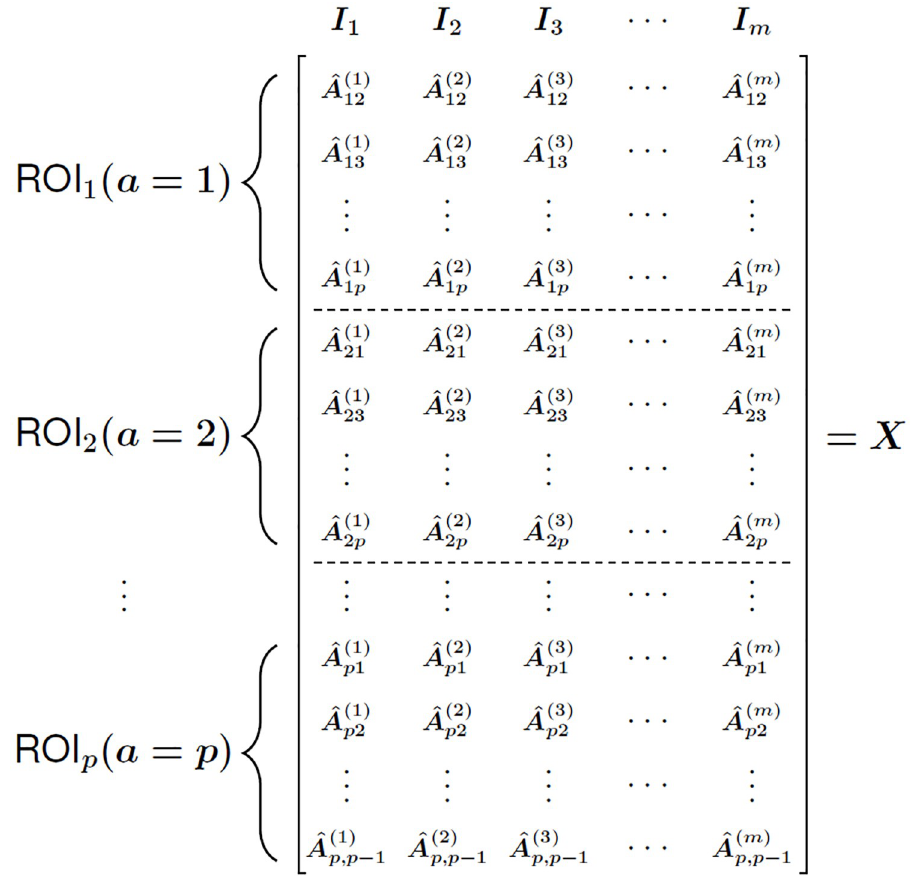
Fig 9. Organization based on brain regions of interest (ROIs) of resting-state fMRI correlation dataset consisting of transformed correlation matrices for m subjects. Each column corresponds to an instance (or subject) I and each j subset of rows corresponds to the correlations for an ROI attribute ( p sets). The notation ^ A ð j Þ represents the r-to-z ak transformed correlation between attributes (ROIs) a and k 6¼ a for instance j . represent ROI , and so on until the last p − 1 rows that represent ROI . For a given column of 2 p X , we exclude pairwise correlations between an ROI and itself. Therefore, the matrix does not contain ^ A ð i Þ for any i 2 I or a 2 A . Furthermore, symmetry of correlation matrices means aa that each column contains exactly two of each element of the upper triangle of an instance’s transformed correlation matrix. For example, ^ A ð i Þ ¼ ^ A ð i Þ for k 6¼ a and both will be contained ka ak in a given column of X for each a 2 A . Based on our rs-fMRI diff (Eq 157), the organization of X makes computation of each value of the diff very simple. In order to compute each value of the rs-fMRI diff, we just need to know the starting and ending row indices for a given ROI. Starting indices are given by ¼ ð k (cid:0) 1 Þð p (cid:0) 1 Þ þ 1 ; for k ¼ 1 ; 2 ; . . . ; p start k and ending indices are given by ¼ k ð p (cid:0) 1 Þ ; for k ¼ 1 ; 2 ; . . . ; p : end k